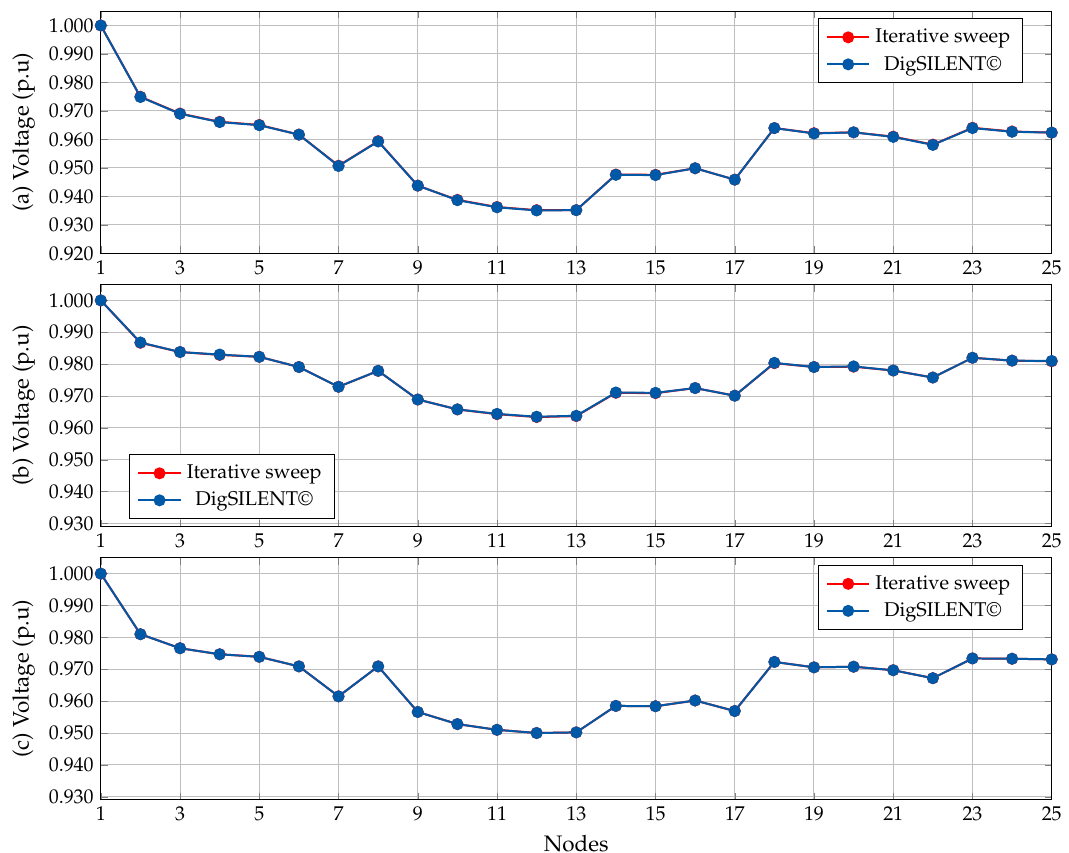
Figure 10. Voltage profiles in the 25-node test system: ( a ) phase A, ( b ) phase B, and ( c ) phase C.